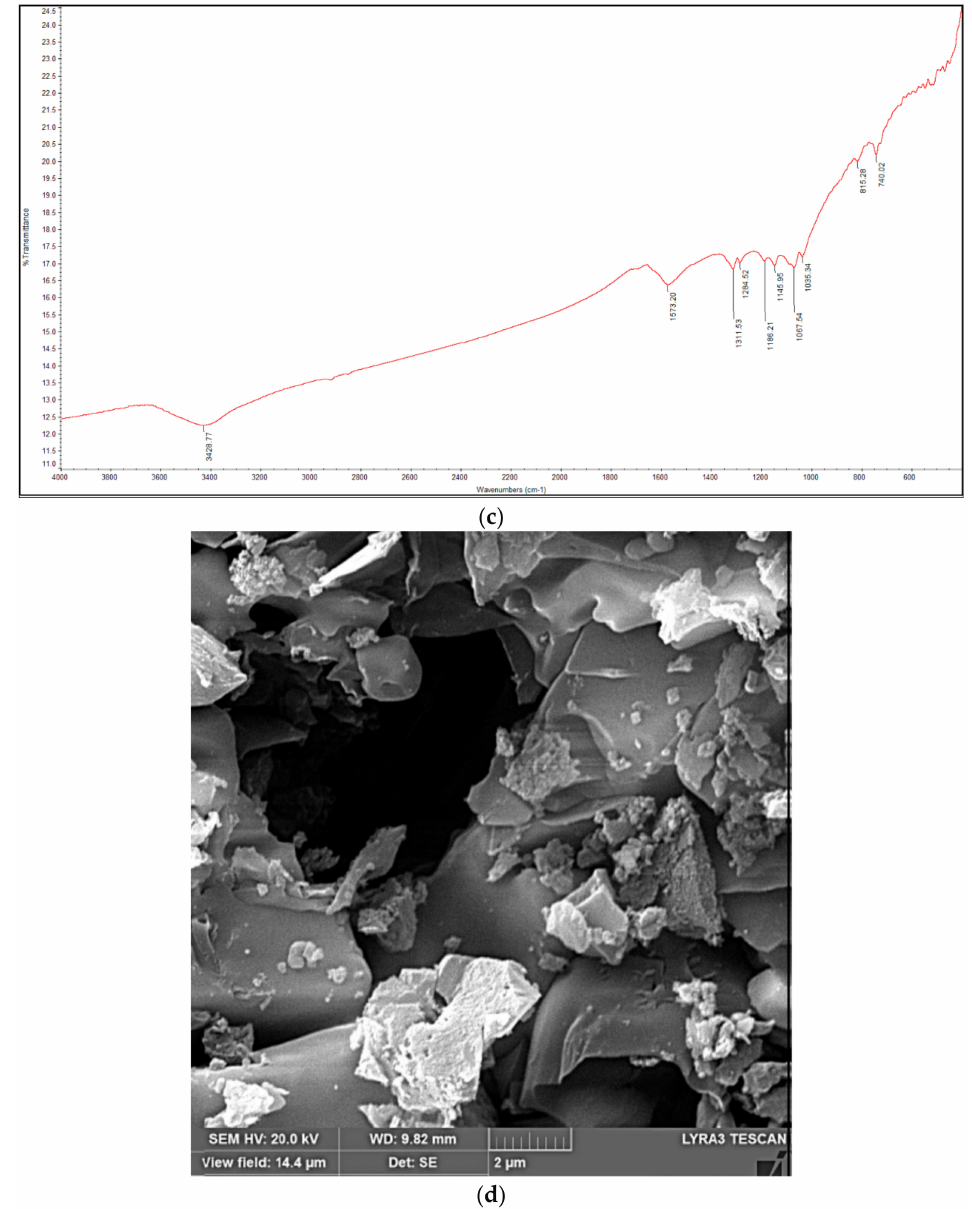
Figure 1. ( a ) The experimental setup used for the dynamic continuous ammonia gas flow adsorption experiments. ( b ) The BET adsorption isotherm findings for the date pits granular activated carbon (GAC) (Preparation conditions: Phosphoric acid (60% w / w ); Impregnation ratio 1.6 mL / g (acid / date-pits); Furnace temperature 500 ◦ C for 2 h). ( c ) The transmittance vs wavenumber Fourier Transform Infrared Spectroscopy (FTIR) findings for the produced GAC (Preparation conditions: Phosphoric acid (60% w / w ); Impregnation ratio 1.6 mL / g (acid / date-pits); Furnace temperature 500 ◦ C for 2 h). ( d ) SEM findings for the GAC produced from date palm pits (Preparation conditions: Phosphoric acid (60% w / w ); Impregnation ratio 1.6 mL / g (acid / date-pits); Furnace temperature 500 ◦ C for 2